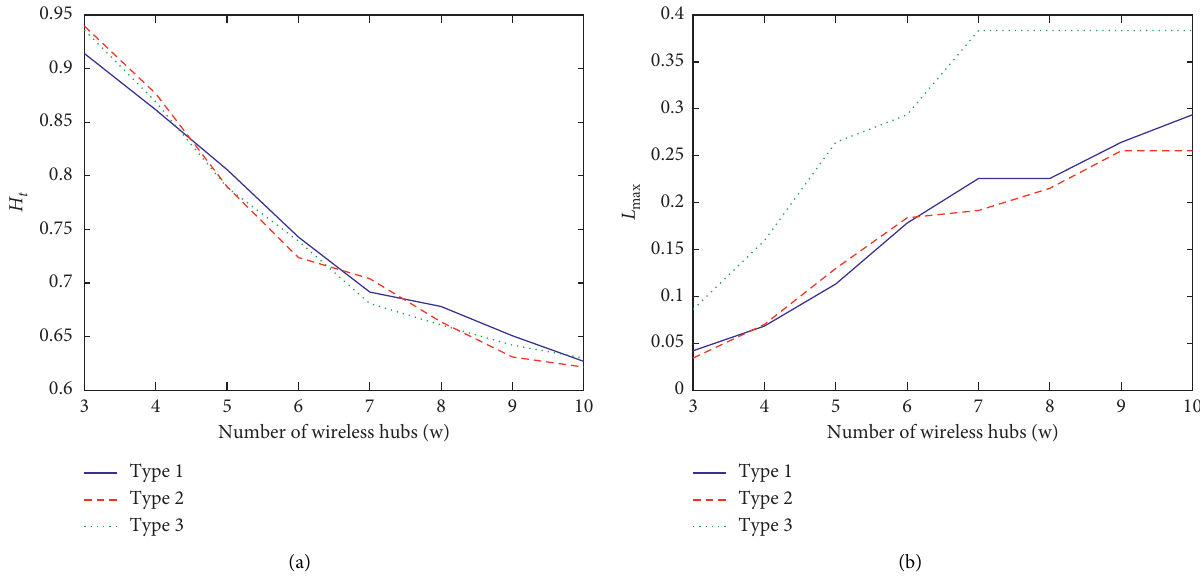
Figure 6: (a) The normalized total number of hops versus n